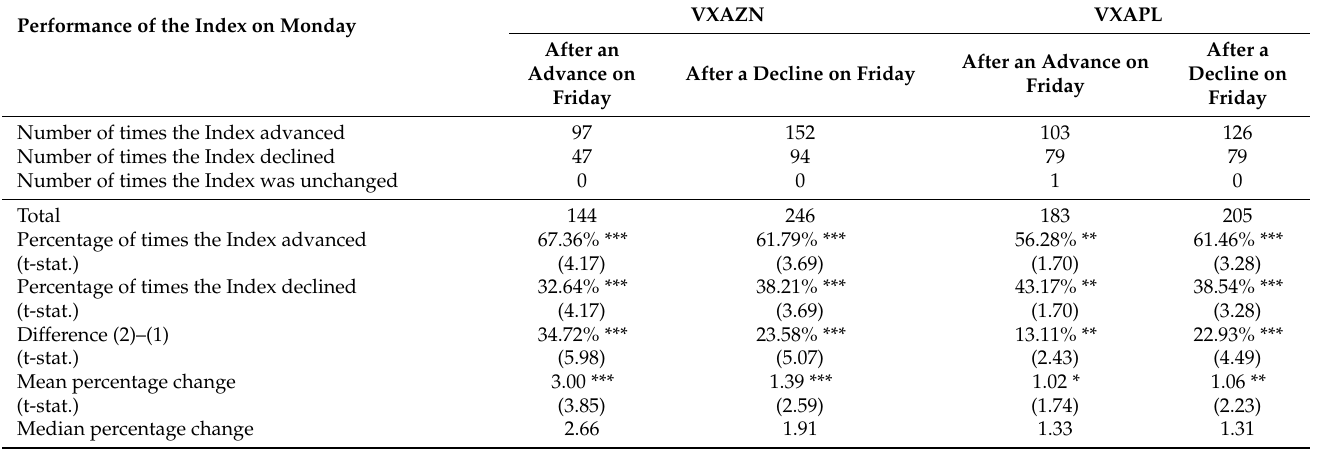
Table 7. Changes in the VIX on Monday contingent on its direction of change on